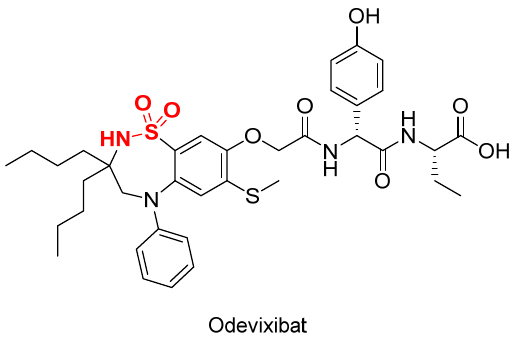
Figure 1. Chemical structure of odevixibat. The sulfonamide moiety is shown in red.